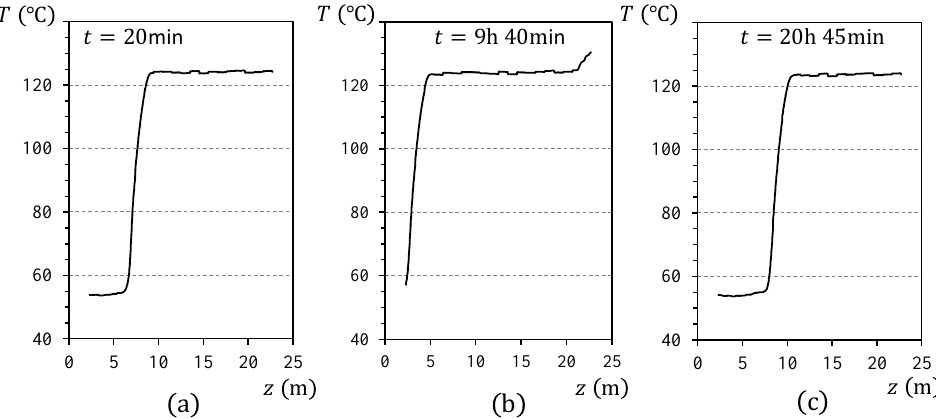
Figure 4. Detailed enhanced temperature profiles for the instants in Figure 3: ( a ) the beginning of charge; ( b ) after the charge and ( c ) after the discharge